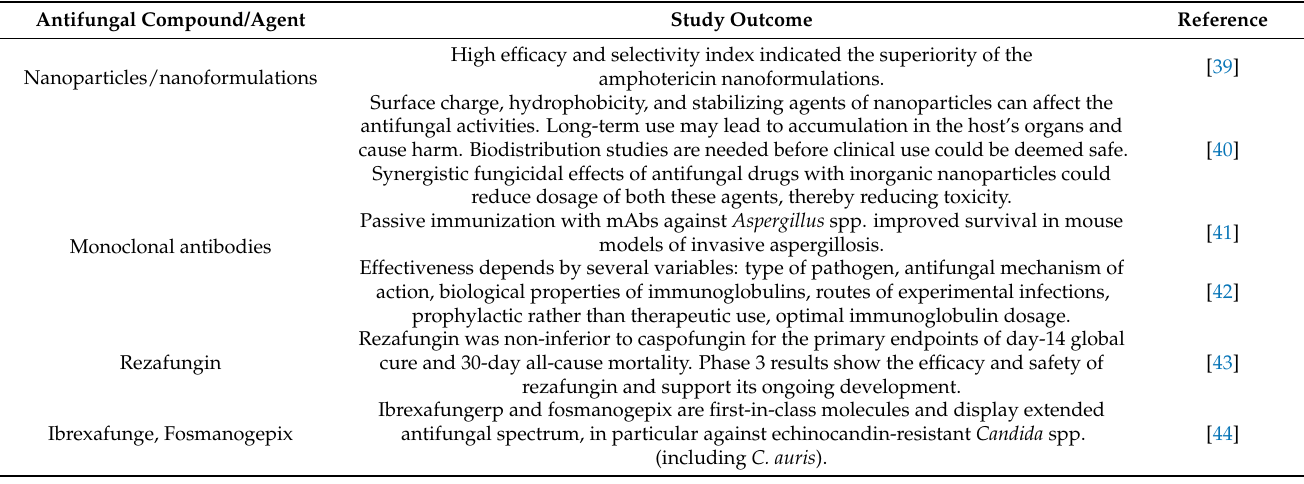
Table 2. New antifungal agents and principal study